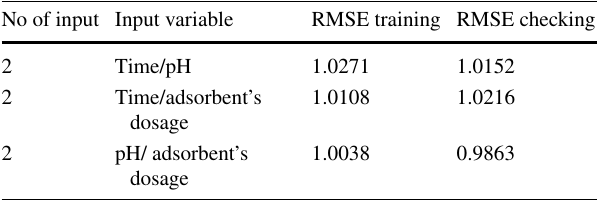
Table 6 Two-input variable ANFIS (exhaustive search) for vanadium